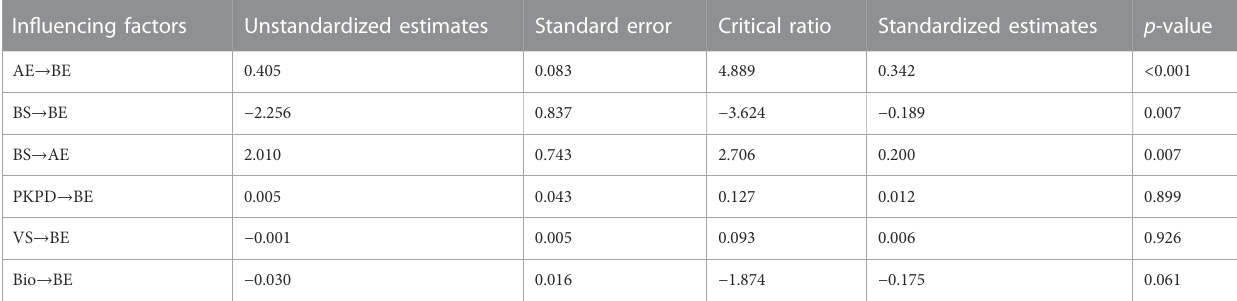
TABLE 2 Parameter estimation of the structural equation